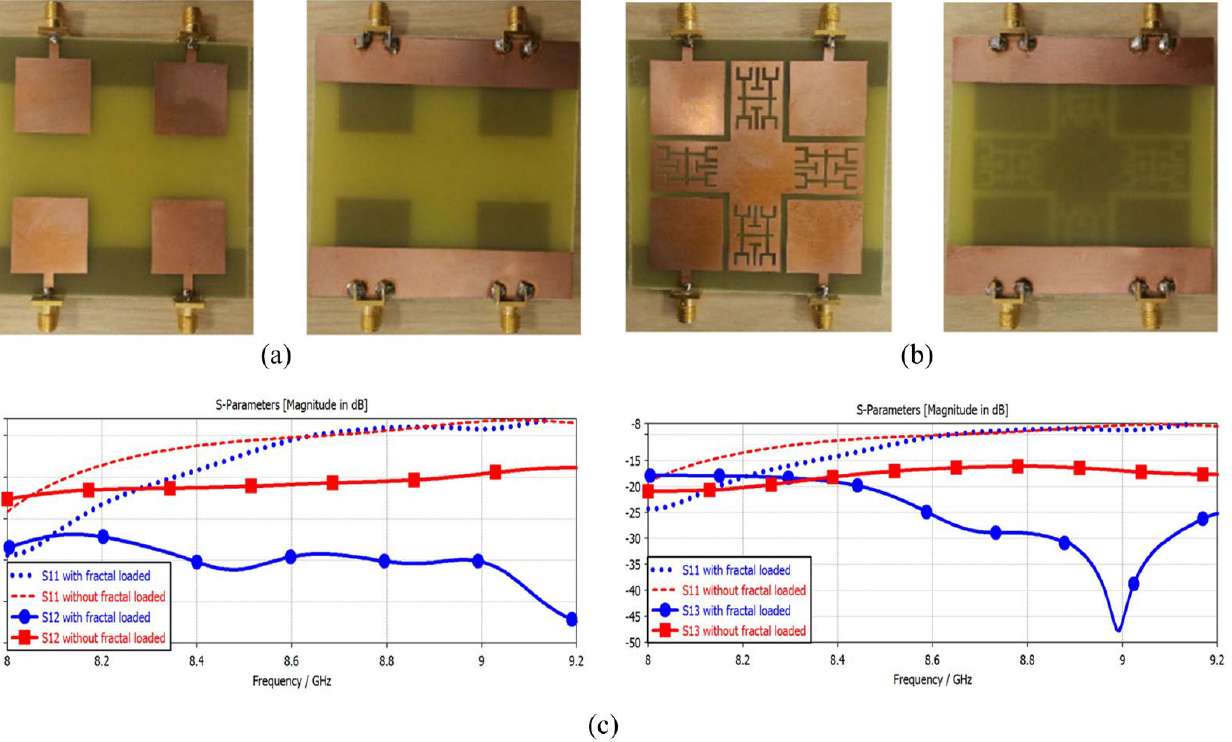
Figure 9. Fabricated prototype of MIMO antenna ( a ) without decoupling structure, ( b ) with decou- pling structure. ( c ) S-parameters of MIMO antenna with and without structure. Reprinted from Ref. [90].